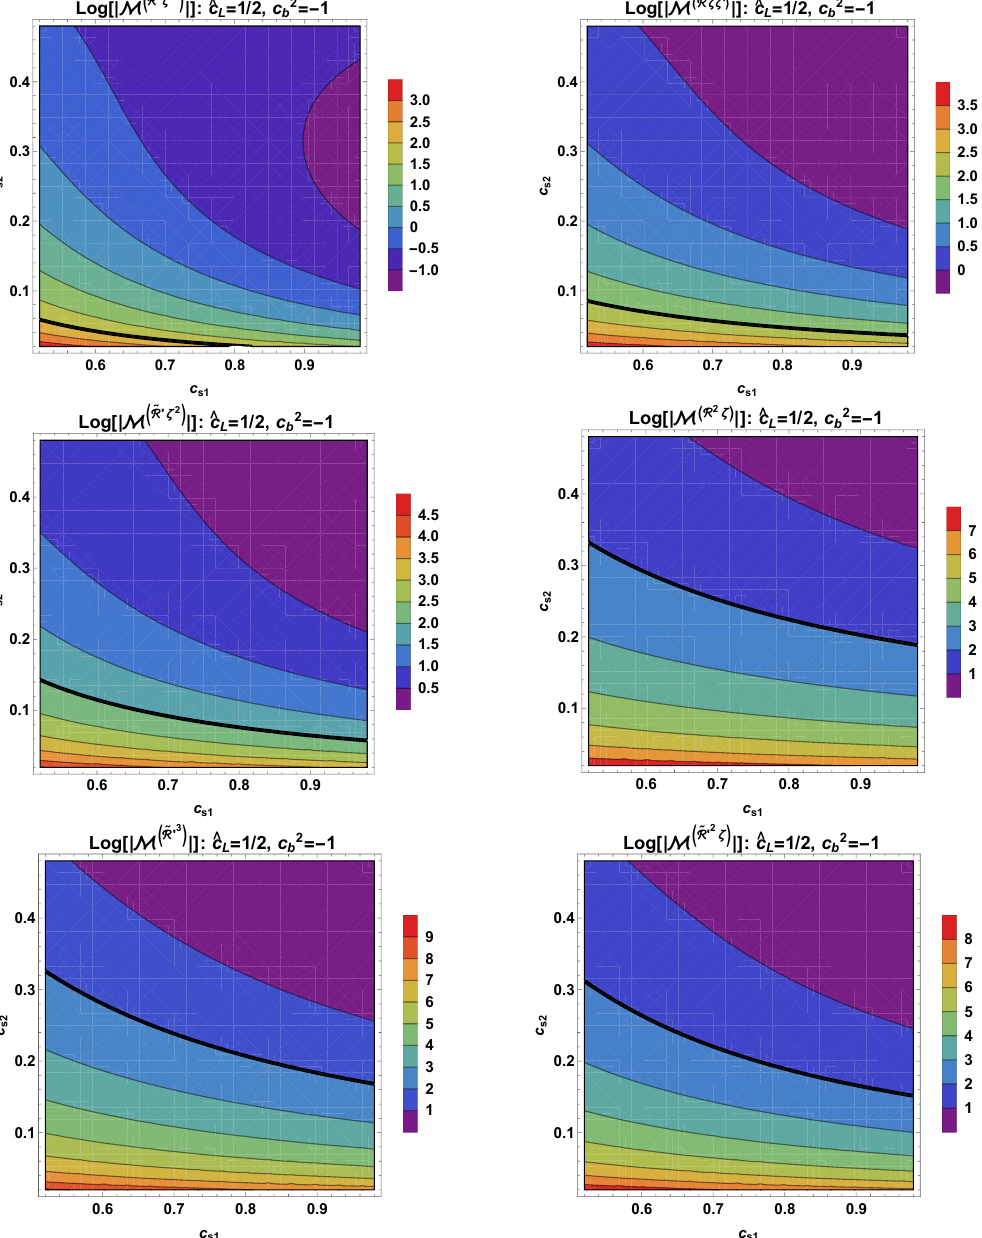
Figure 9 . B 1 ,..., 5 , G 1 , 2 and O 1 , 2 squeezed vertices. The black line delimits the region where M O ∼ 10 2